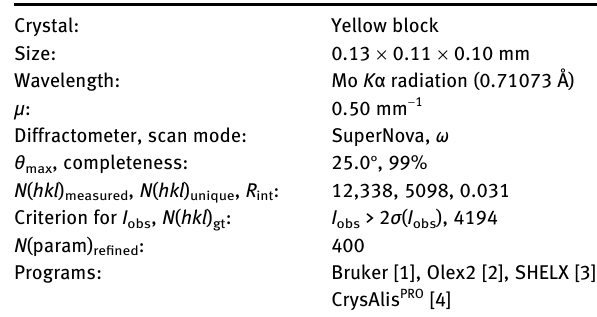
Table  : Data collection and